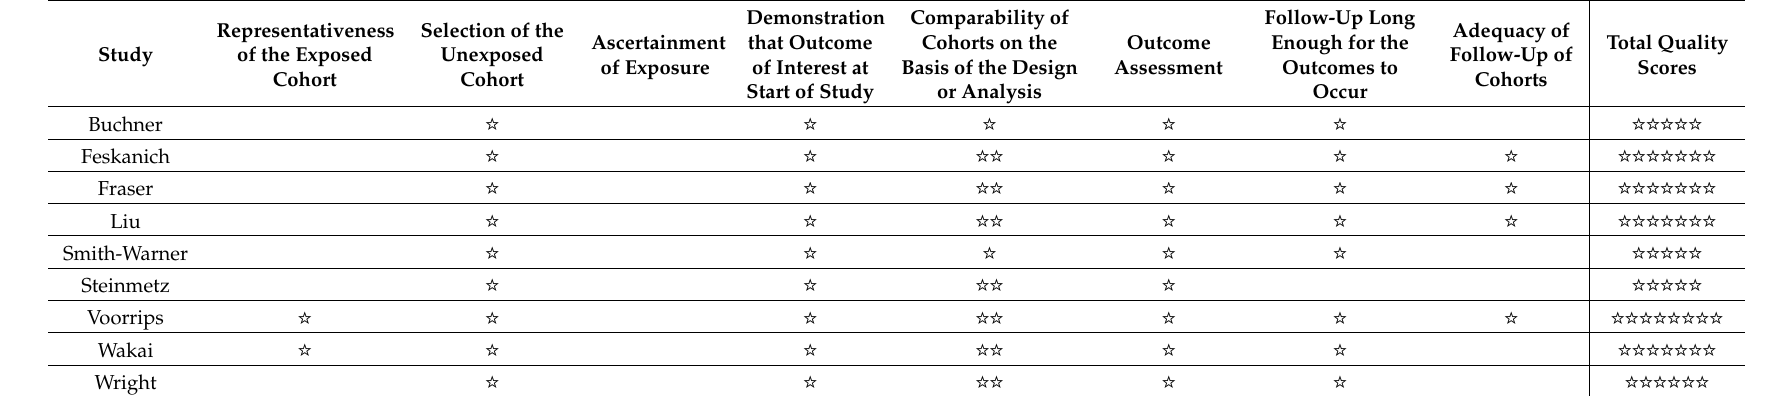
Table 2. Quality assessment of each included study according to Newcastle-Ottawa Scale.